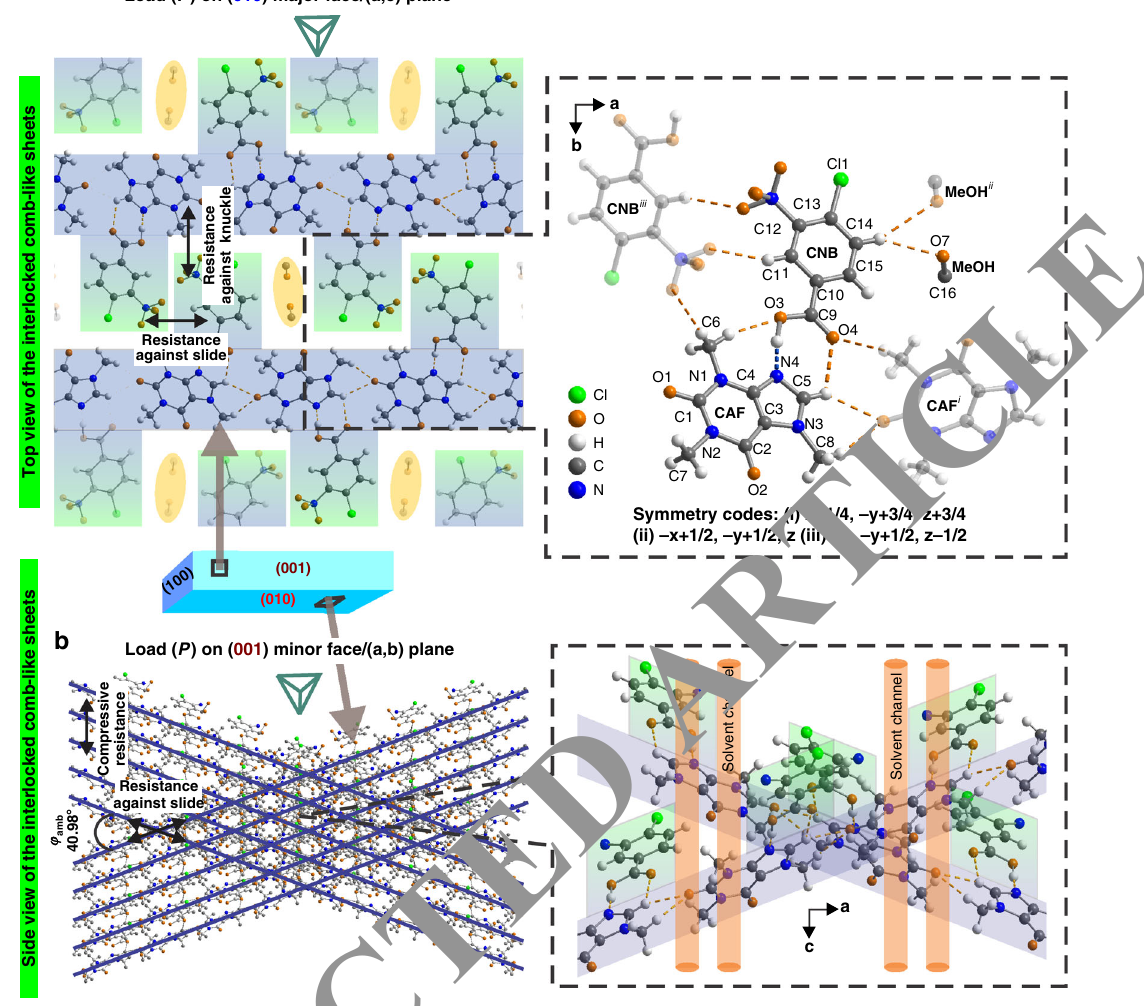
Fig. 2 Crystal packing and schematic representation of resistance to external load. Geometry and packing of the comb-like tapes (blue-green shades) viewed along c ( a ) and along b ( b ). The zipper-like conformation of the comb-like tapes resists deformation by knuckling, sliding and compression against external load on (010) and (001) faces. Inset of a shows the atom labels with intermolecular interactions. Molecular graphics with thermal ellipsoids can be found in Supplementary Fig.